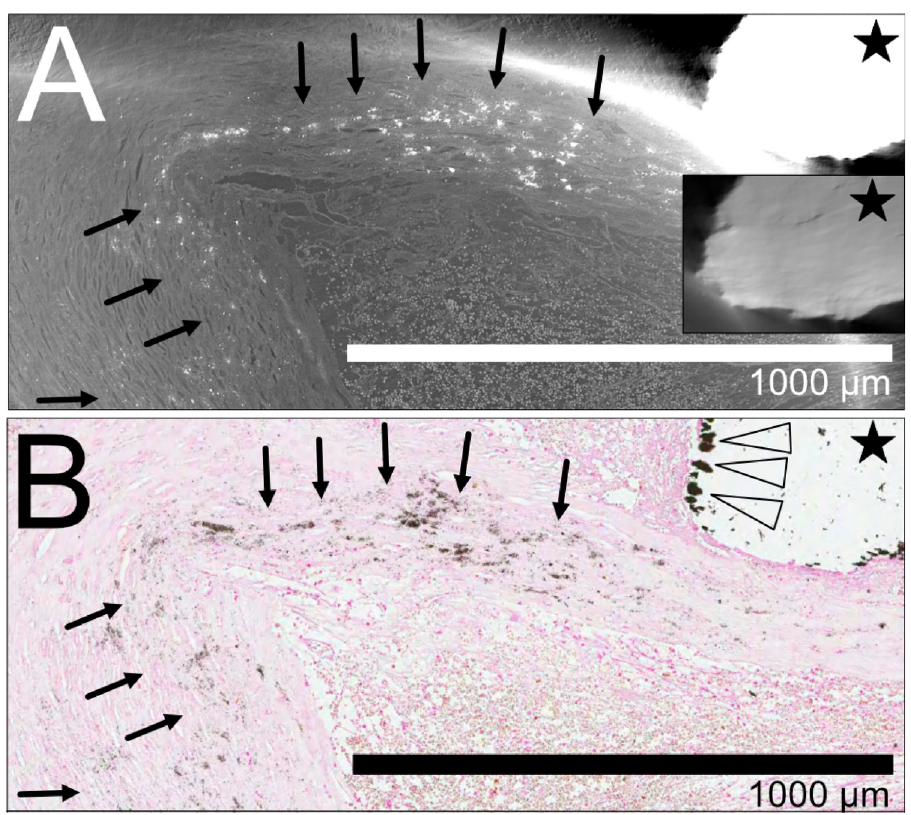
Fig 6. Calcifications. The black star in (A) indicates part of a macrocalcification in the HR SR μ CT where regions of high density appears as saturated. With a wider dynamic range of the grey levels, more details are visible within the calcification (inset in (A) ). (B) histological section of the corresponding area, stained for calcifications (von Kossa), where only the macrocalcification’s fragmented rim remains after the histologic preparation (arrowheads). In (A) and (B) , the black arrows indicate microcalcifications. Plaque ID 1 in S1 Table in S1 File.